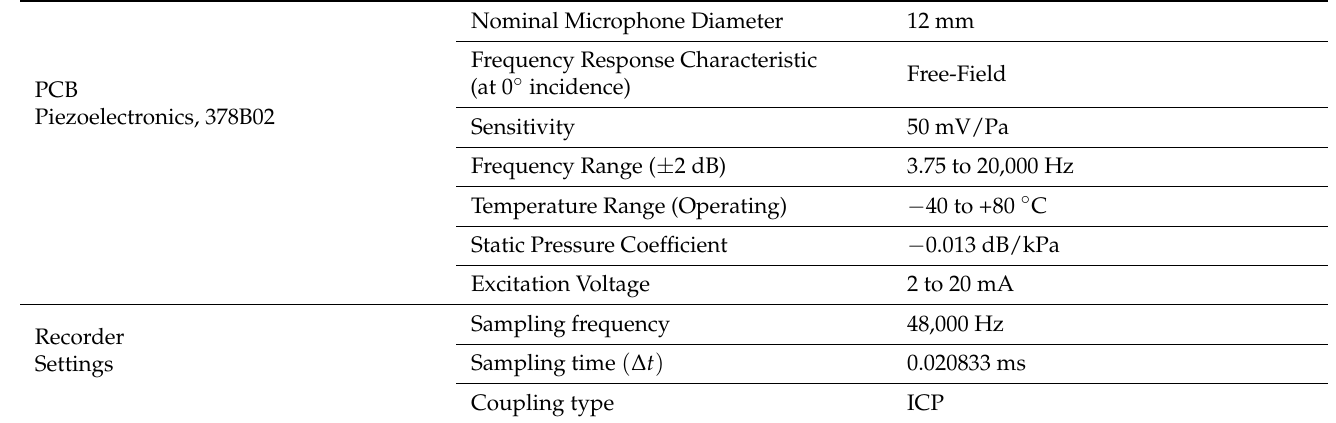
Table 1. Technical specifications of the